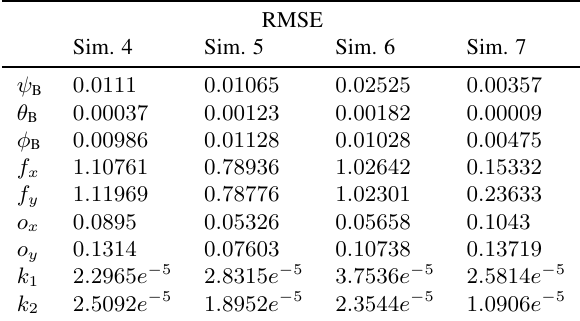
Table 3: This table shows the RMSE of the calibration parameters achieved by performing 100 Monte Carlo trials for the optimiza- tion with an fixed lever-arm for various flight